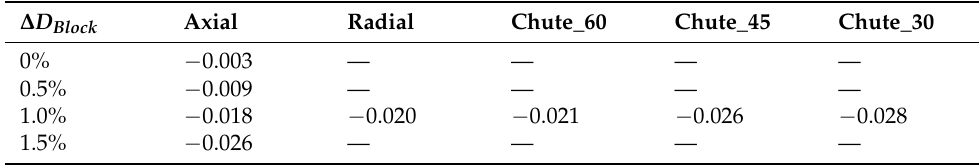
Table 3. Blocking loss (dm 3 ).